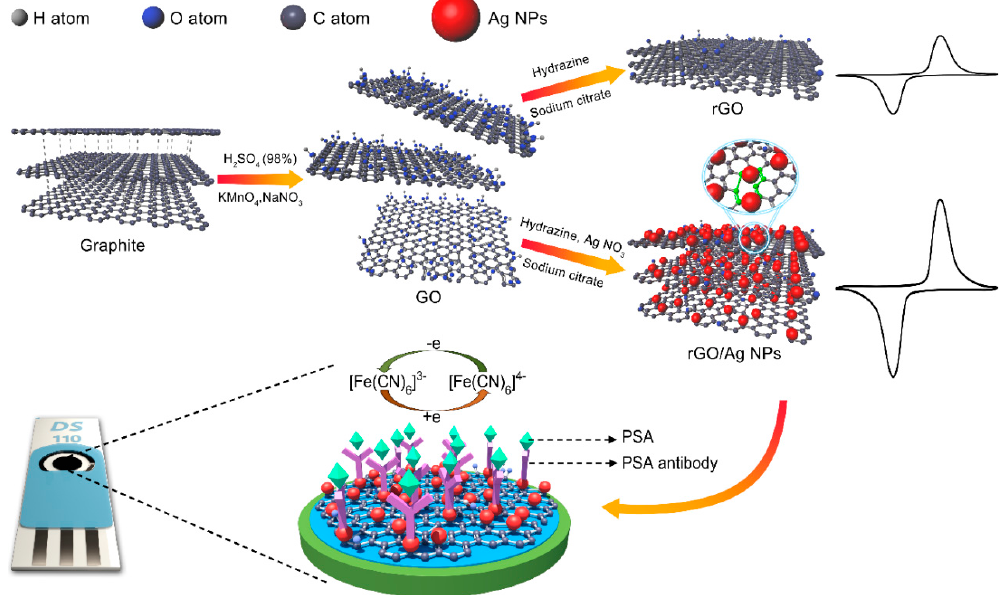
Figure 14. Preparing process of rGO (reduced graphene oxide) and rGO/Ag NPs as well as schematic illustration of fabricated electrochemical immunosensor for PSA (prostate specific antigen) detection.